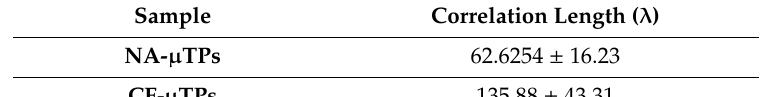
Table 3. Correlation length analysis.